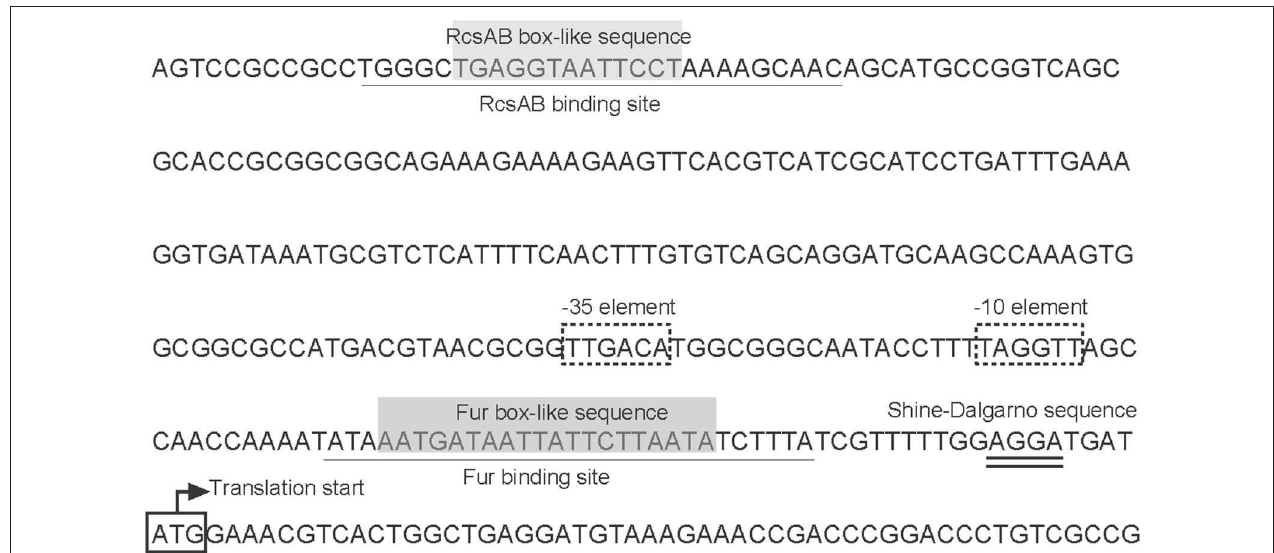
FIGURE 6 | Organization of entC promoter-proximal DNA regions. The DNA sequences were derived from NTUH-K2044. Shown are the translation start sites, − 10 and − 35 elements, Shine-Dalgamo sequence, RcsAB-binding site, RcsAB box-like sequence, Fur-binding site and Fur box-like sequence.